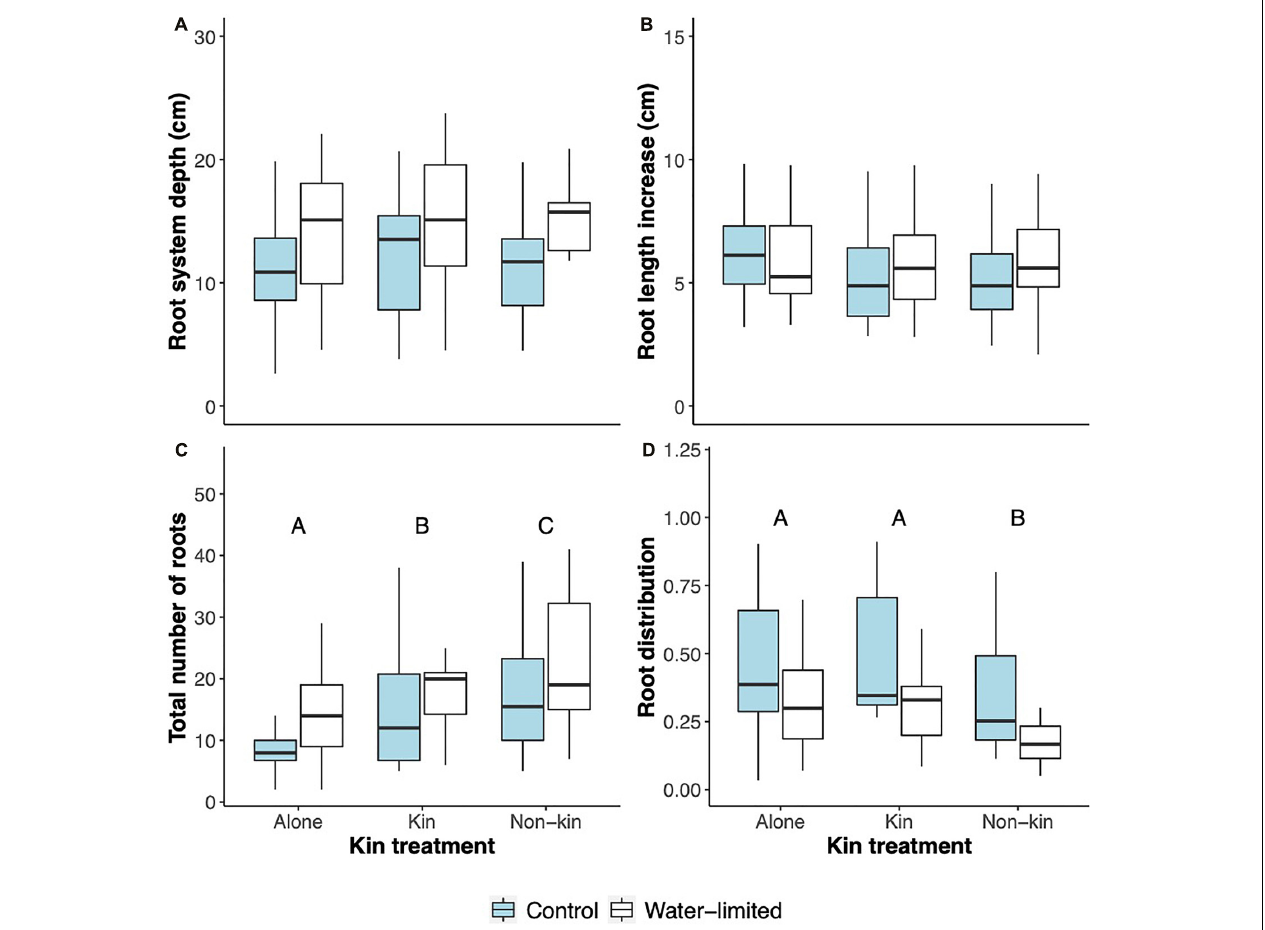
FIGURE 4 | Boxplots of (A) maximum root system depth (cm), (B) root length increase, (C) total number of roots, and (D) proportion of roots in the lower 2/3 of boxes of Glechoma hederacea plants grown alone, with a kin or with a non-kin plant in control (blue boxes) and water-limited (white boxes) conditions in Experiment 2. Letters above bars indicate significant